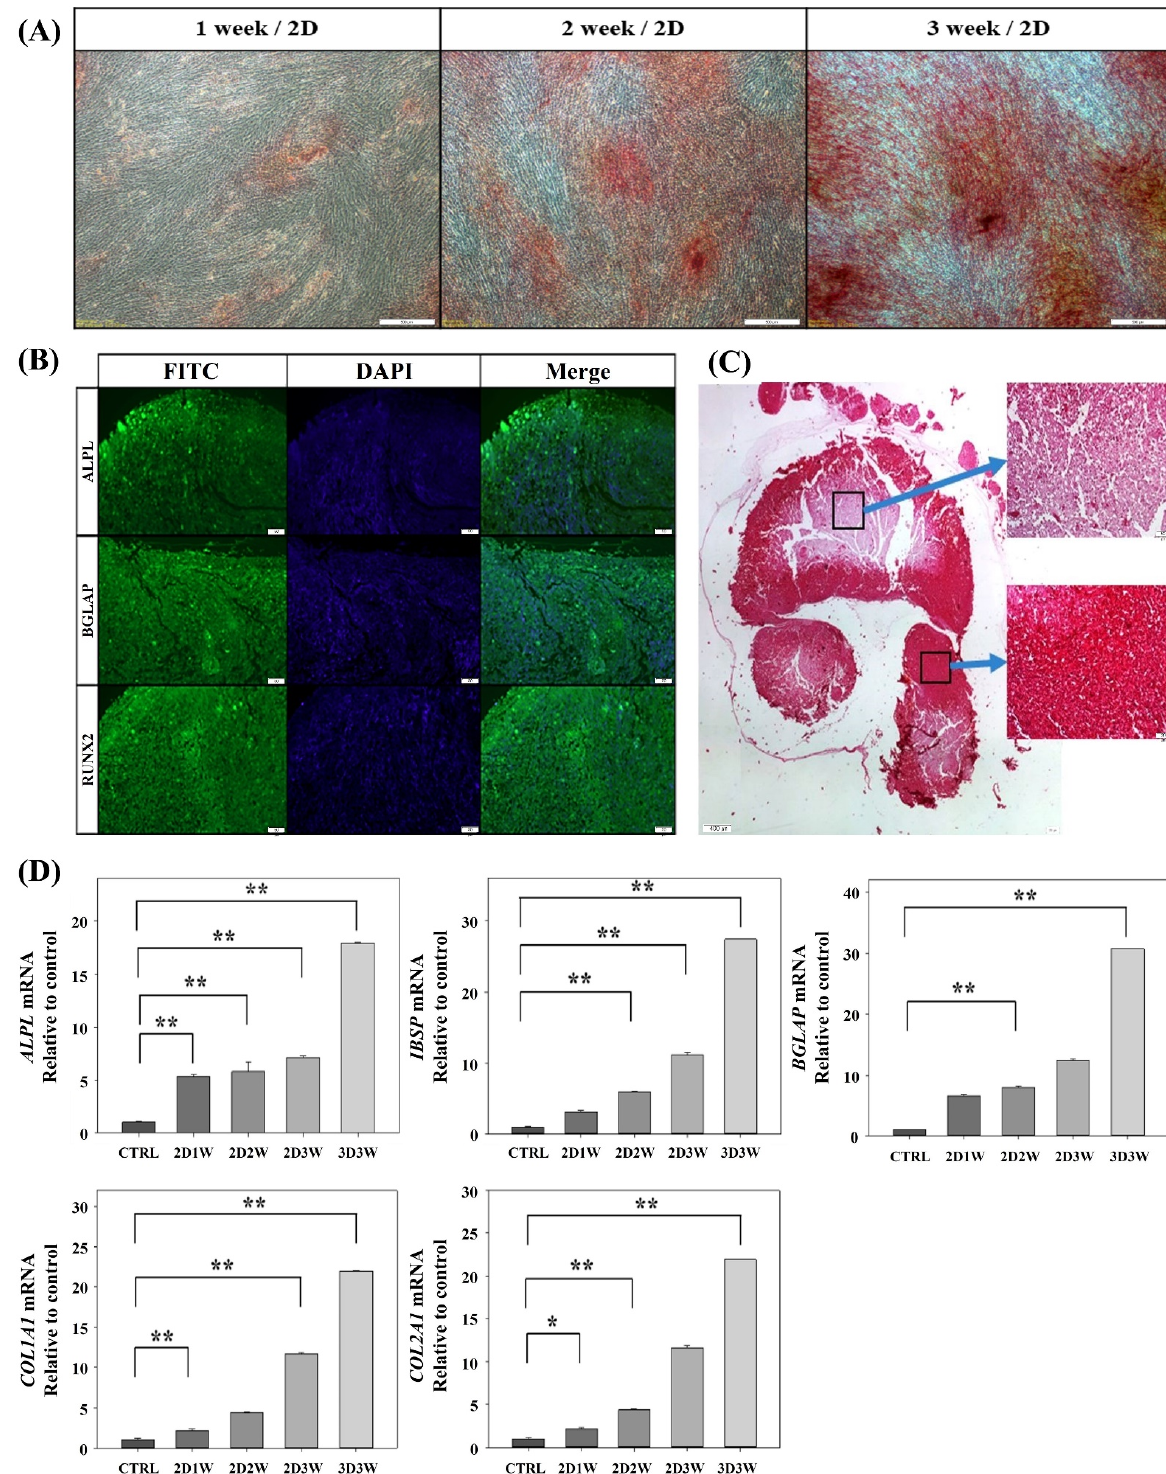
Figure 2. Osteogenic differentiation of hADSCs in 2D and 3D culture conditions. ( A ) Alizarin red staining (ARS) of differentiated hADSCs in 2D culture condition. hADSCs were seeded in a six-well microplate and cultured for three weeks. Every week, the culture samples were fixed and stained. Scale bar, 500 µ m ( B ) Immunohistochemical staining was carried out to investigate osteogenic differentiation. Osteogenic differentiation markers were used such as ALPL , BGLAP and RUNX2 . Scale bar, 50 µ m ( C ) ARS staining of a sliced osteogenic differentiated hADSCs spheroid at three weeks. Scale bar, 400 µ m, 50 µ m, respectively. ( D ) Quantitative real-time PCR (qRT–PCR) analysis for osteogenic marker expression in 2D and 3D culture conditions. Five genes were used to check for osteogenic differentiation. * p < 0.1, ** p < 0.05 vs control